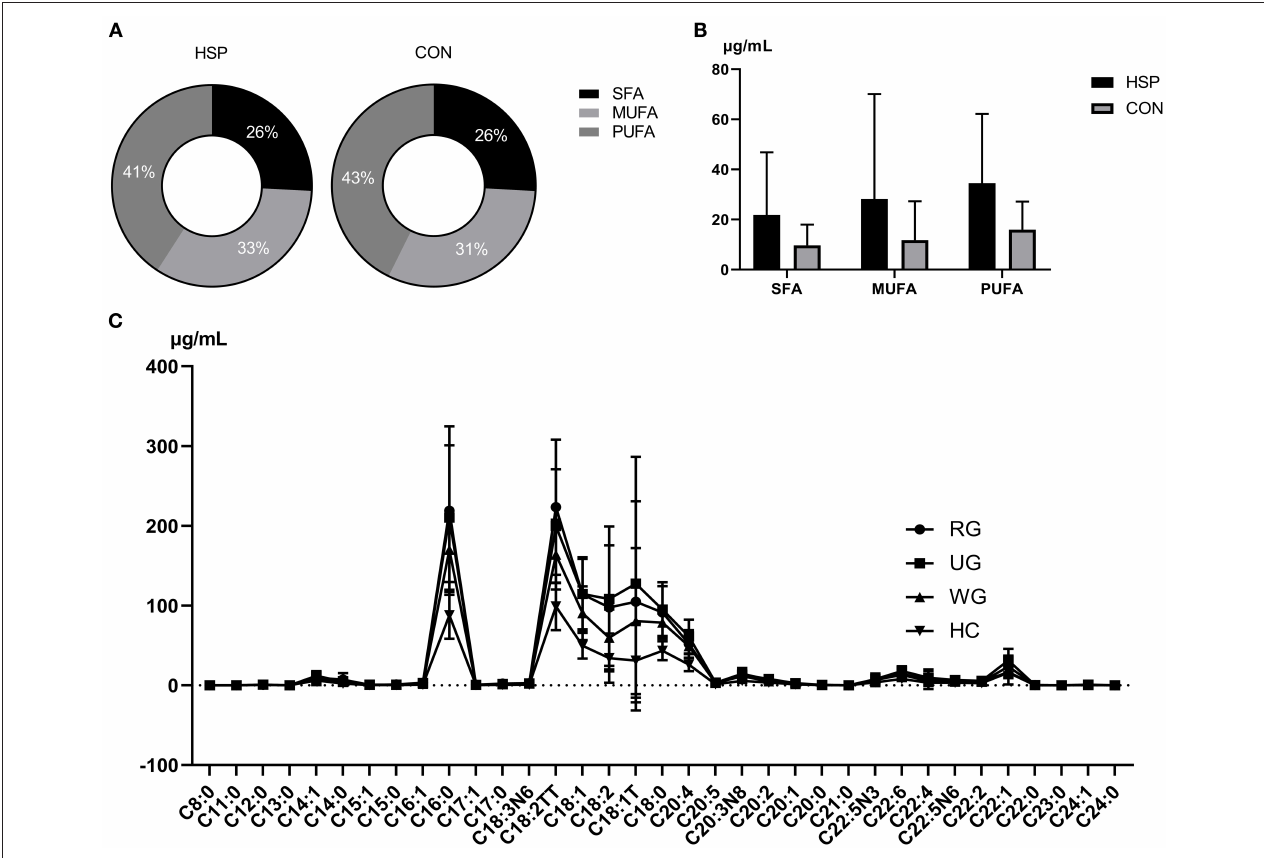
FIGURE 1 | Percent (A) and content (B) comparison of SFAs, MUFAs, and PUFAs between HSP group and CON group. (C) Distribution and correlations of 35 fatty acids among three groups of HSP and CON group. RG means regular treated group, UG means the untreated group, WG means the withdrawal group. Data are means ±